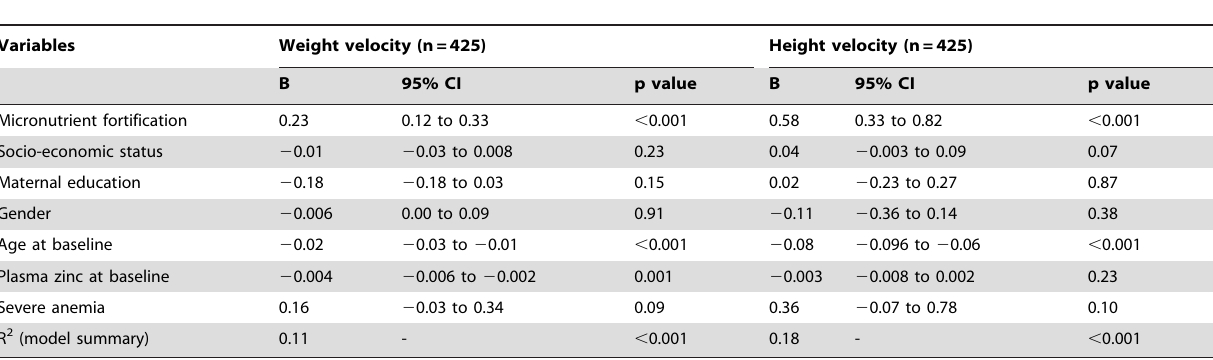
Table 4. Multiple linear regression a evaluating the effect of micronutrient fortification on weight velocity and height velocity of children after 1 year of